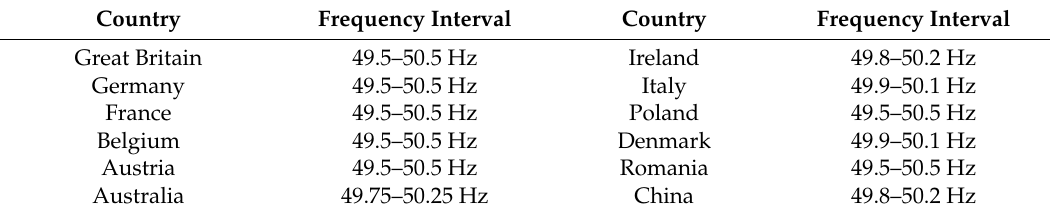
Table 3. Normal operation frequency variation intervals [1,11,13–21].